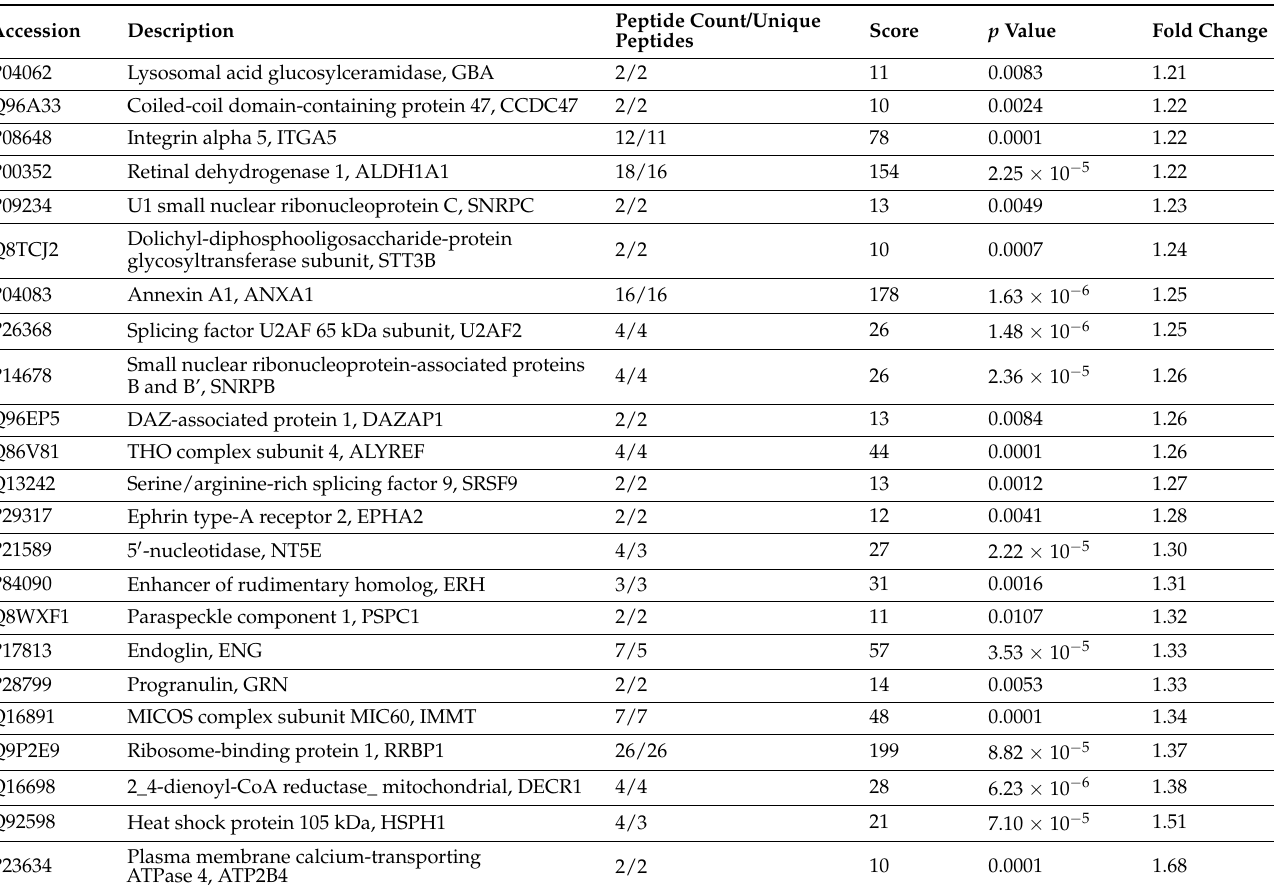
Table 2. List of the proteins identified by LC-MS E analysis and increased by PTX3 silencing in the EC